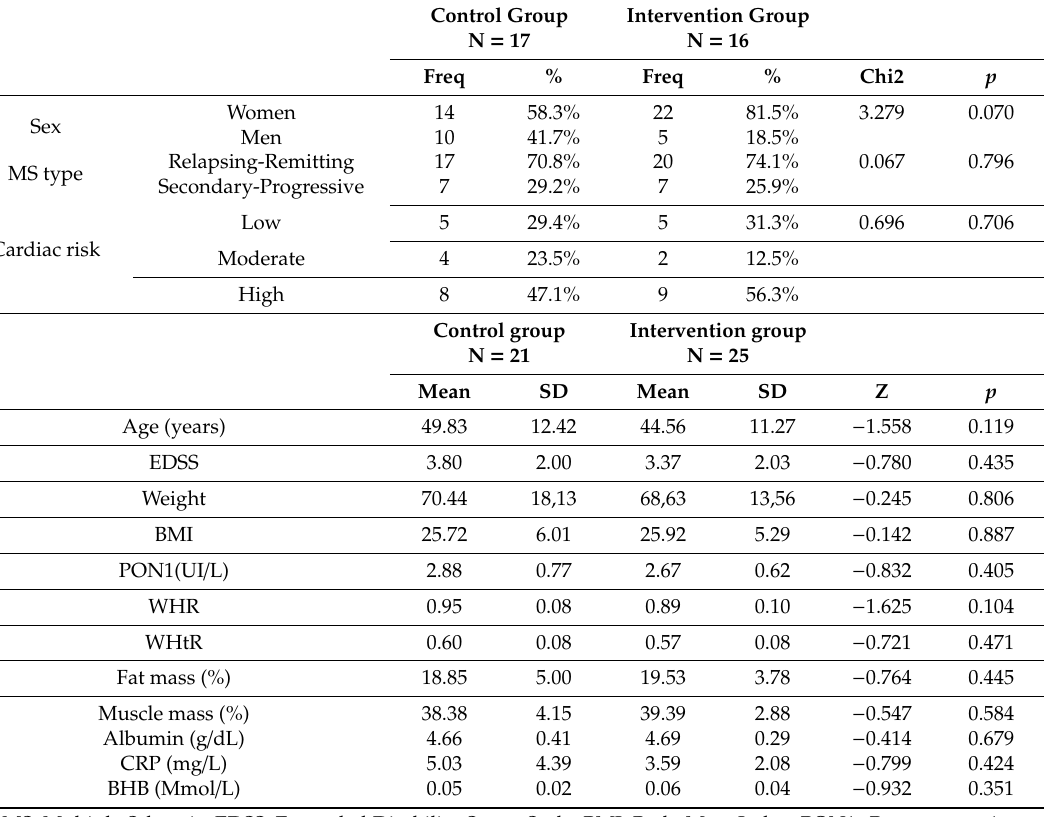
Table 1. Sociodemographic and clinical characteristics of the population of the study. Comparison between di ff erent groups at